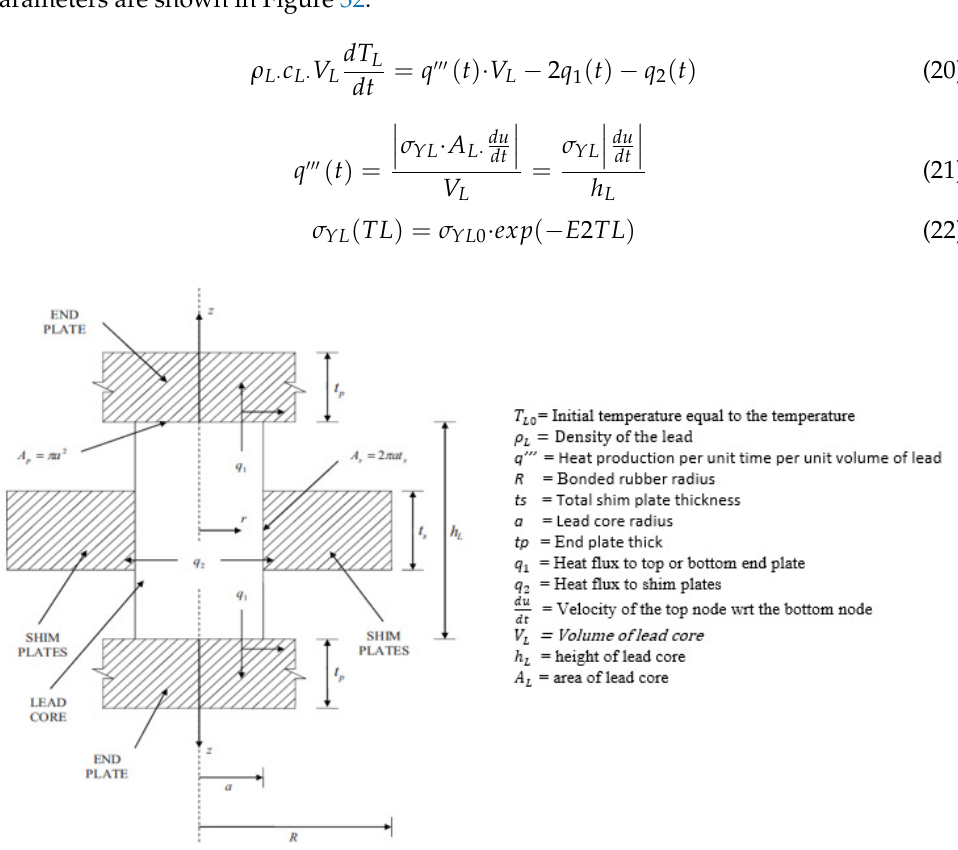
Figure 32. Idealized LRB layout for the strength degradation based on the heating of lead plug [145,146] .